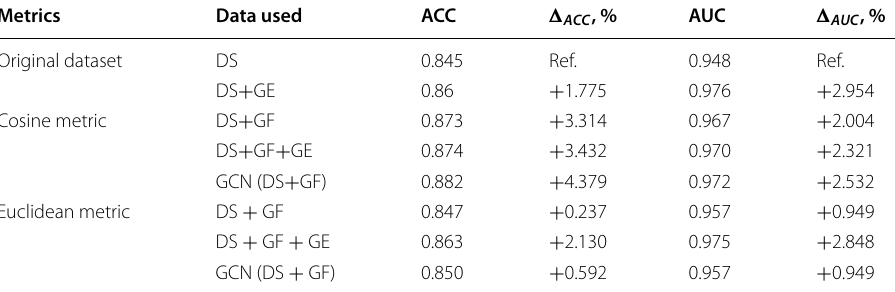
Table 7 Comparative analysis of classification models applied to data enhanced with graph concepts